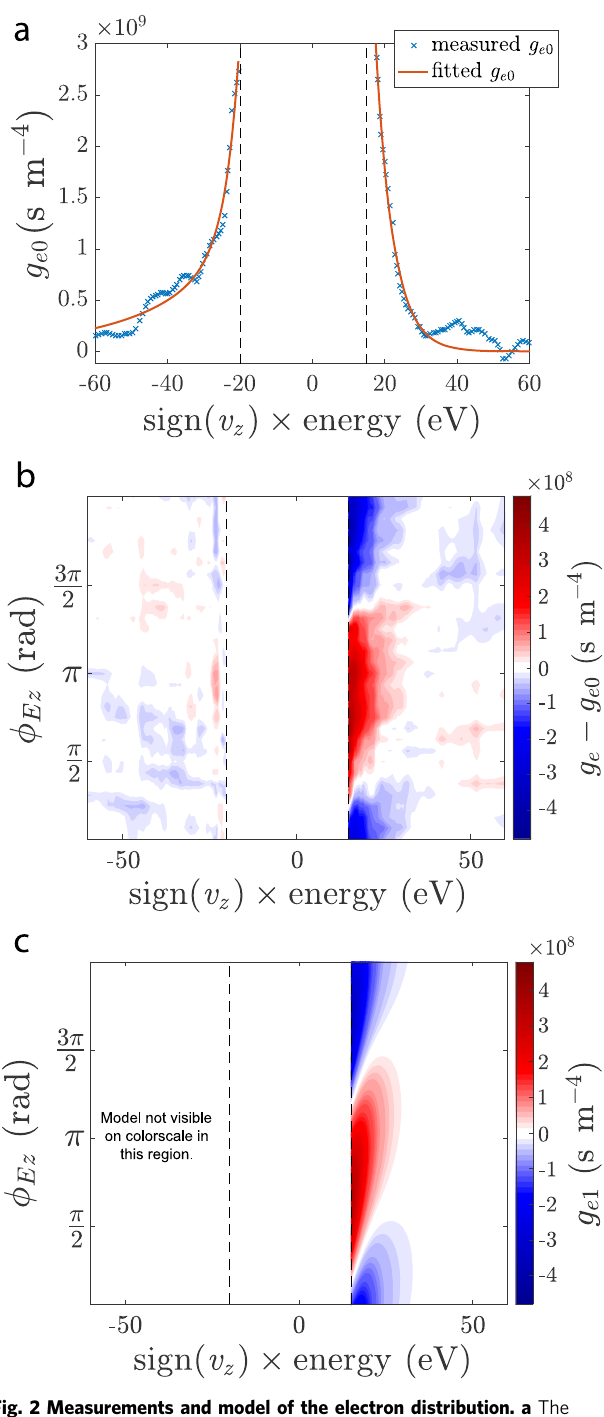
Fig. 2 Measurements and model of the electron distribution. a The background distribution g e 0 ( v z ) obtained by averaging g e ( v z ) over Alfvén wave phase ϕ referenced to E z . b Measured perturbations δ g e are E z coherent with Alfvén wave phase ϕ . c A solution to the linearized E z Boltzmann equation accurately models g e 1 caused by Alfvén waves in this experiment. WWAD measurements of g e ( v z ) are unavailable in the region between the vertical dashed oscillating with the same phase relative to the Alfvén wave as slower electrons. As we will show, this difference in phase means that in some regions of velocity space the electrons gain energy, while in other regions they lose energy, ultimately producing a signature characteristic of resonant energy transfer 46 – 48 .